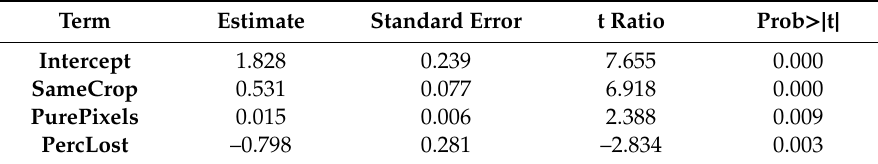
Table 5. Estimated parameters of the regression model and their significant